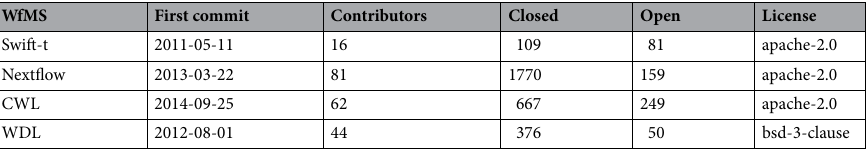
Table 3. GitHub activities from each WfMS (March 4th, 2021). Contributors is the number of contributors in each repo, Open and Closed refer to the count of open and closed issues and pull requests in the repo.